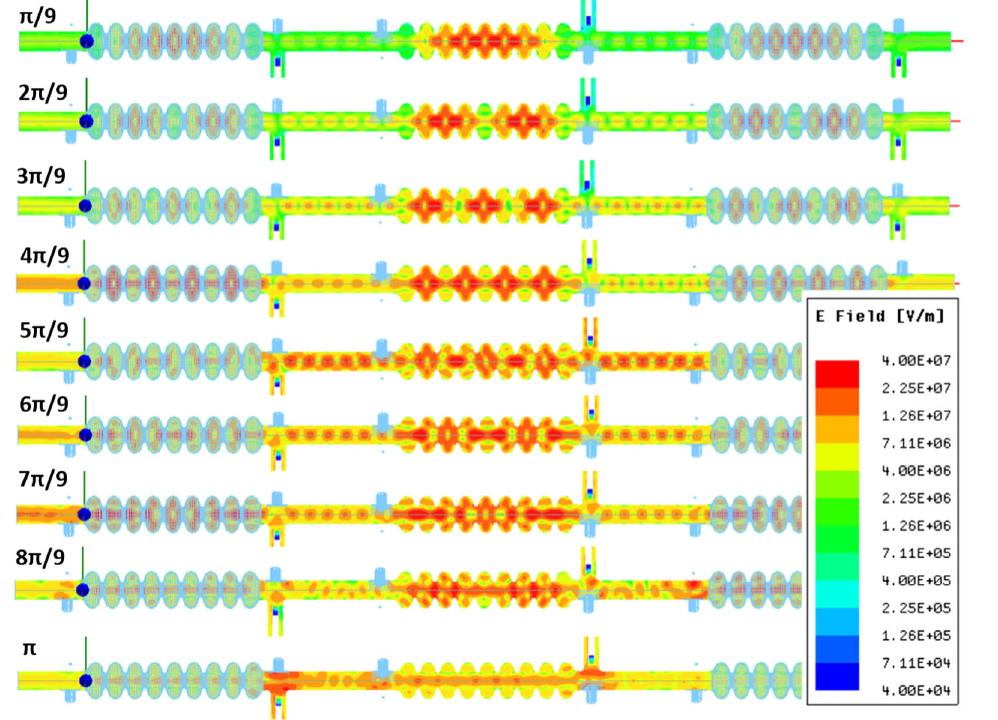
FIG. 4. Complex magnitude of the electric field in the second monopole band (7.048 – 7.612 GHz) of the 3.9 GHz LCLS-II cavity (fields are normalized to 1 J stored energy).